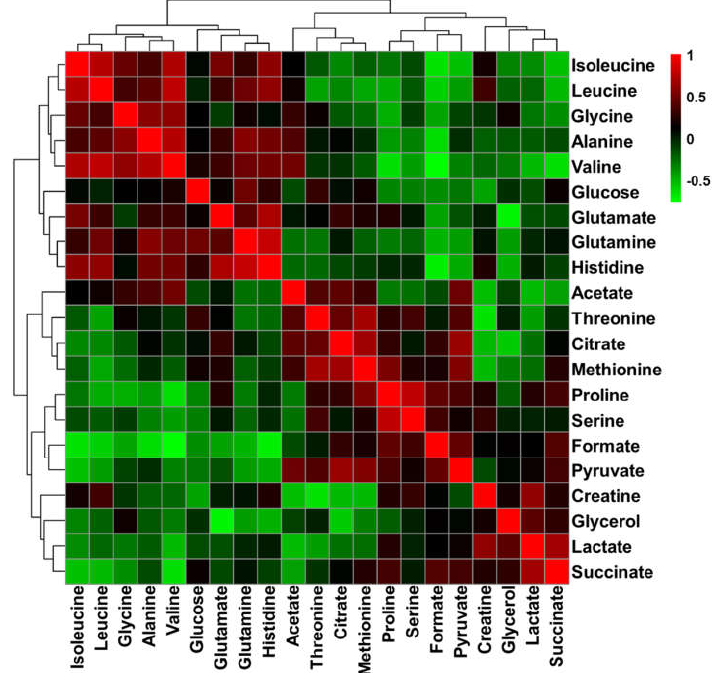
Figure 5. Correlation matrix of metabolites in the serum of dogs. The scale bar shows the correlation coefficient from − 1 to + 1. Metabolites 2020 , 10 , x